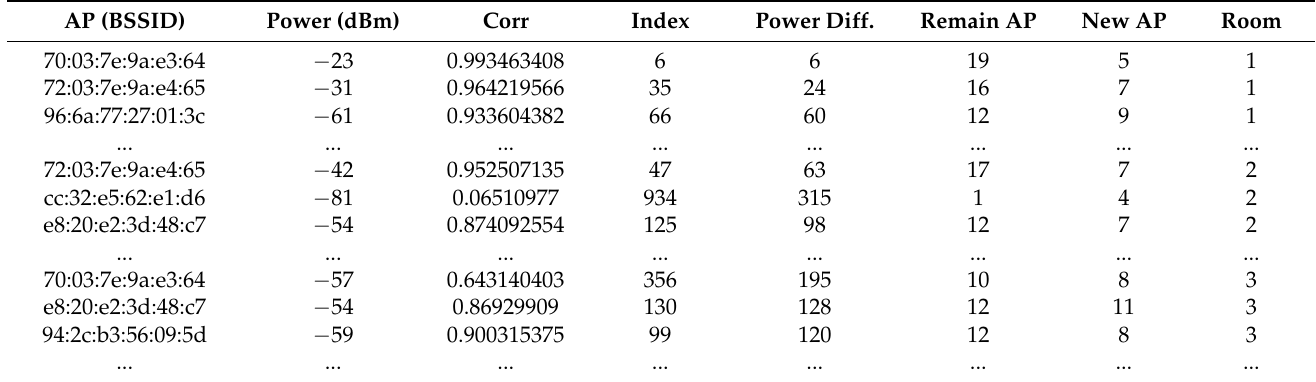
Table 3. Extended dataset with new